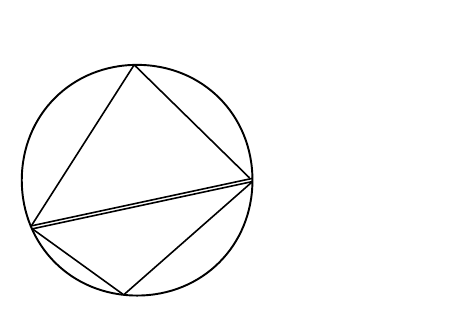
Figure 8 . The dual gauge theory that (cid:13)ows to the same (cid:12)xed point as the one in the previous